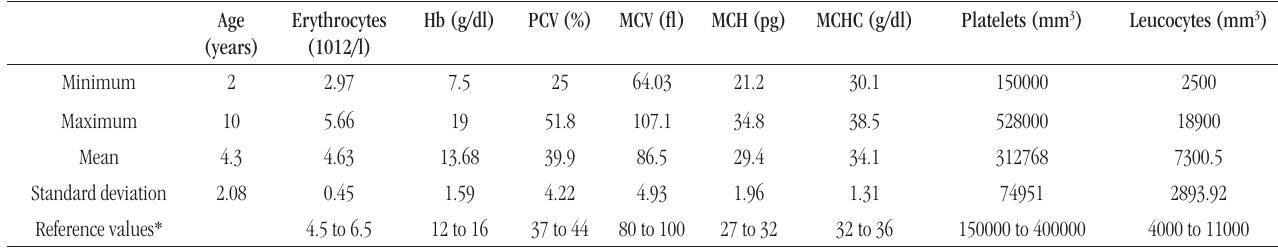
taBLE 1 − Hematological parameters of 203 children with Down Syndrome